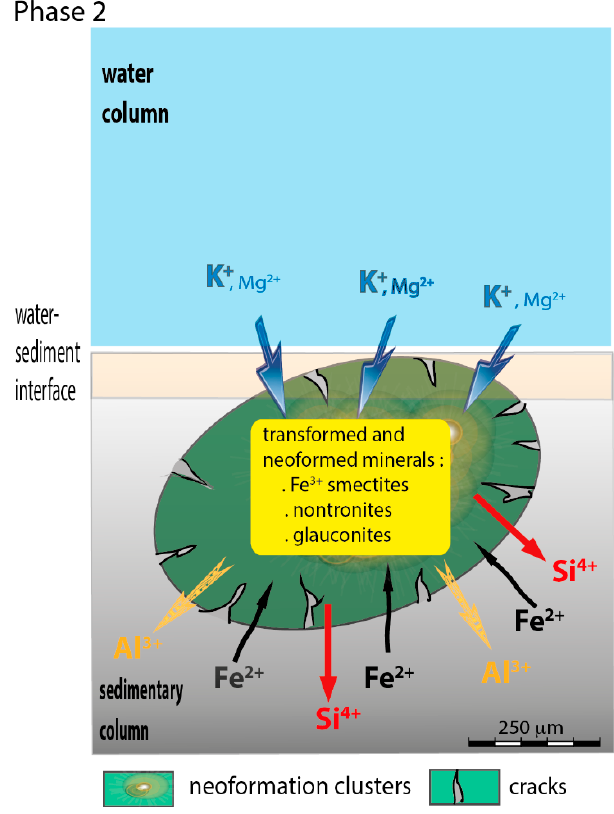
Figure 11. Second phase of schematic evolution of glauconitic grains from pale–medium-green grains to dark-green grains with the mean elementary composition measured by microprobe and established for each class color with the two values on each